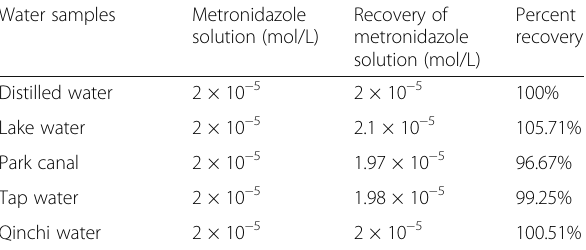
Table 2 Recovery of metronidazole in different water